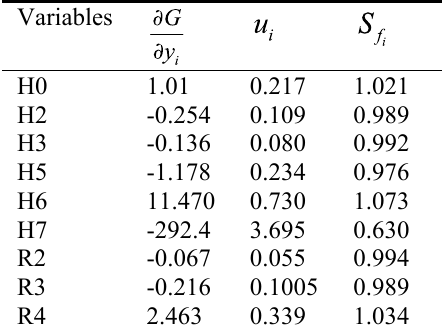
Table 3. Results of the optimal safety factors